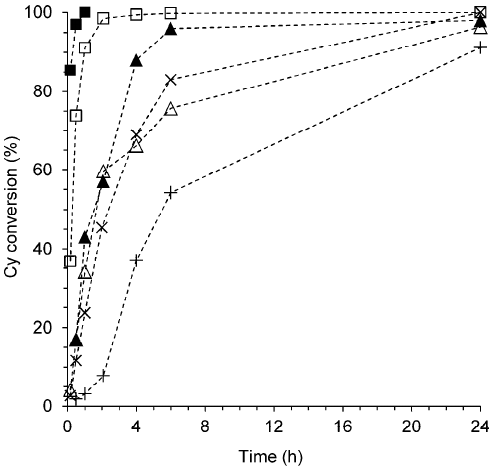
Figure 5. Kinetic profiles for the reaction of cis -cyclooctene with TBHP, in the presence of 1 ( □ ), 2 ( ∆ ), 1 OD ( ■ ), 2 OD ( ▲ ), 3 ( × ) and 4 (+), at 70 °C. The CyO selectivity was always 100%. The dashed lines are visual guides.